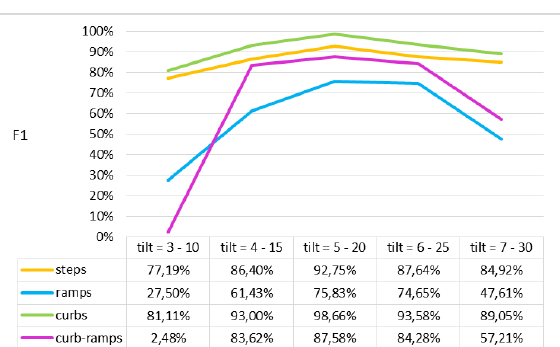
Figure 11. Relation between F1 index and k